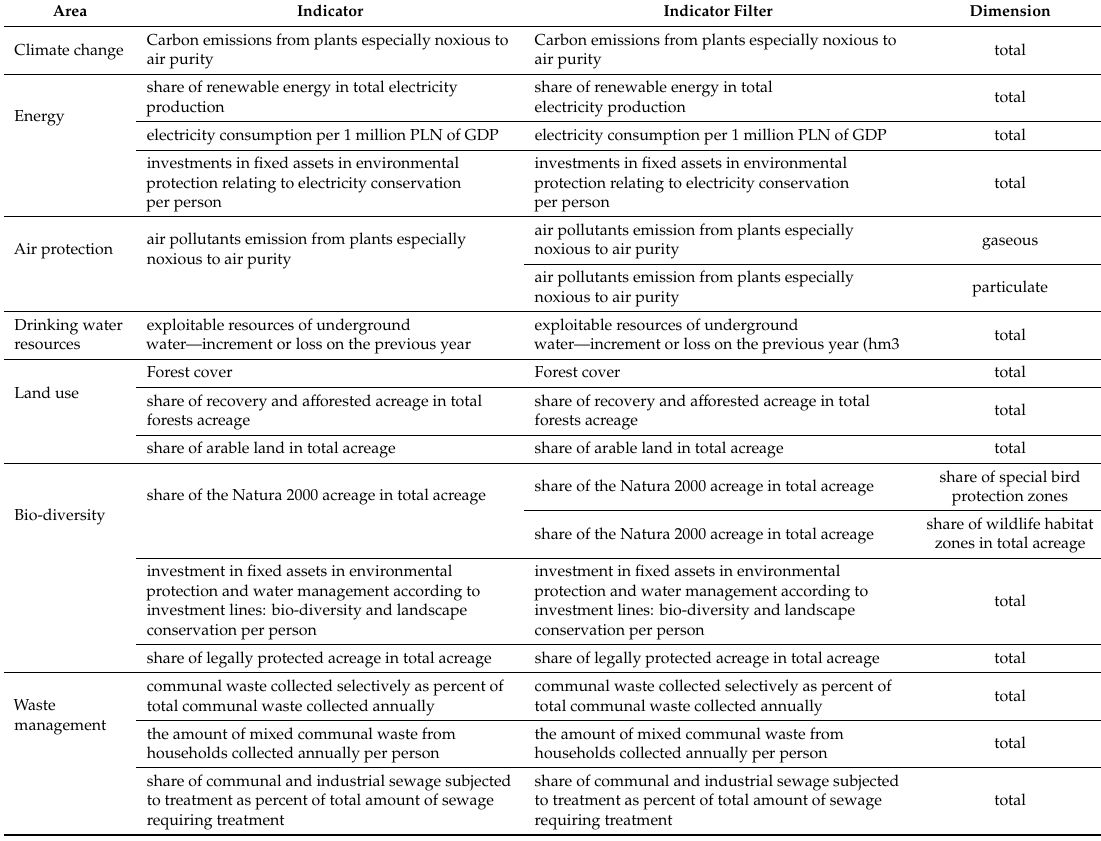
Table 1. Sustainable development indicators in the area of environmental order.